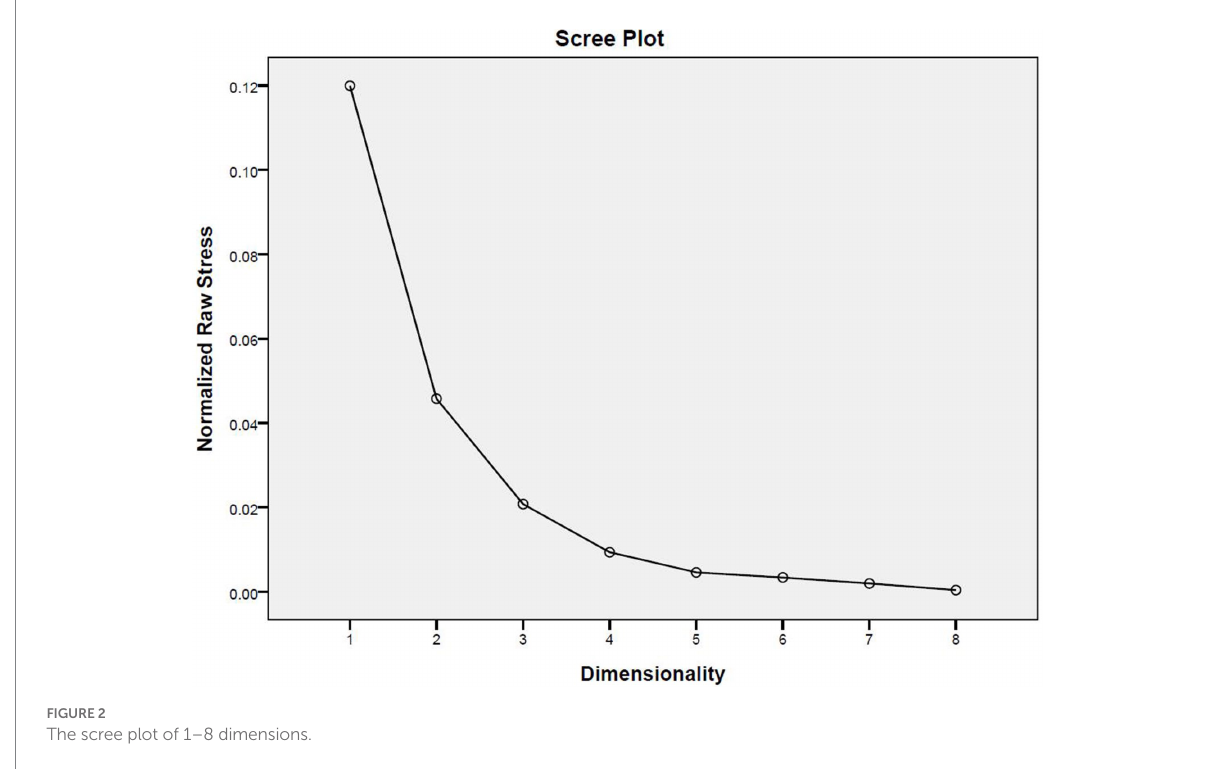
FIGURE 2 The scree plot of 1–8 dimensions.